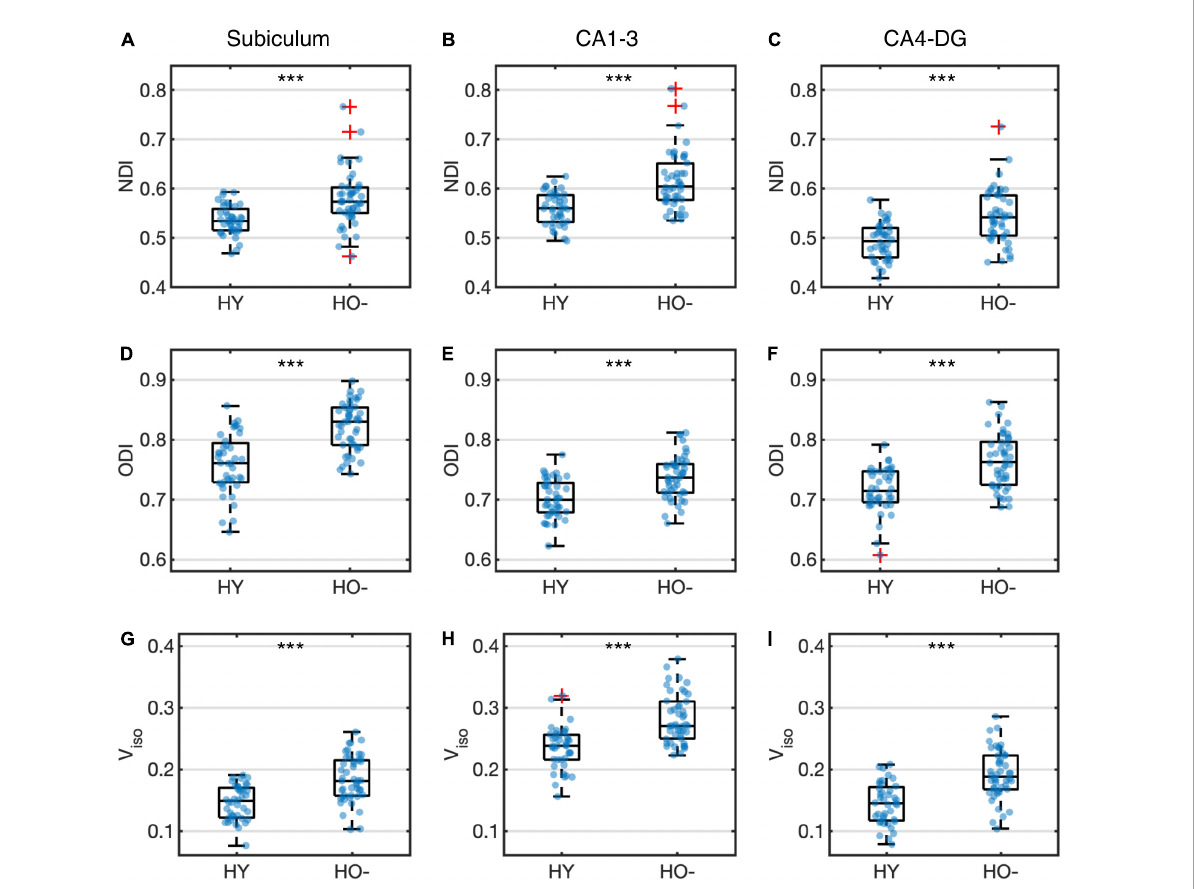
FIGURE4 Group differences of neurite density index (NDI) (A–C) , orientation dispersion index (ODI) (D–F) and volume fraction of isotropic water diffusion (V iso ) (G–I) in the subiculum (A,D,G) , CA1-3 (B,E,H) and CA4-DG (C,F,I) between healthy young adults (HY) and healthy older adults with negative CSF biomarker status (HO − ). Box plots show the median, quartiles and whiskers that represent 1.5 × the interquartile range. P -values were determined using general linear models with sex, normalized whole hippocampal volume, and total intracranial volume as covariates, and adjusted for multiple comparisons using Holm-Bonferroni correction. Significant at *** P < 0.001.